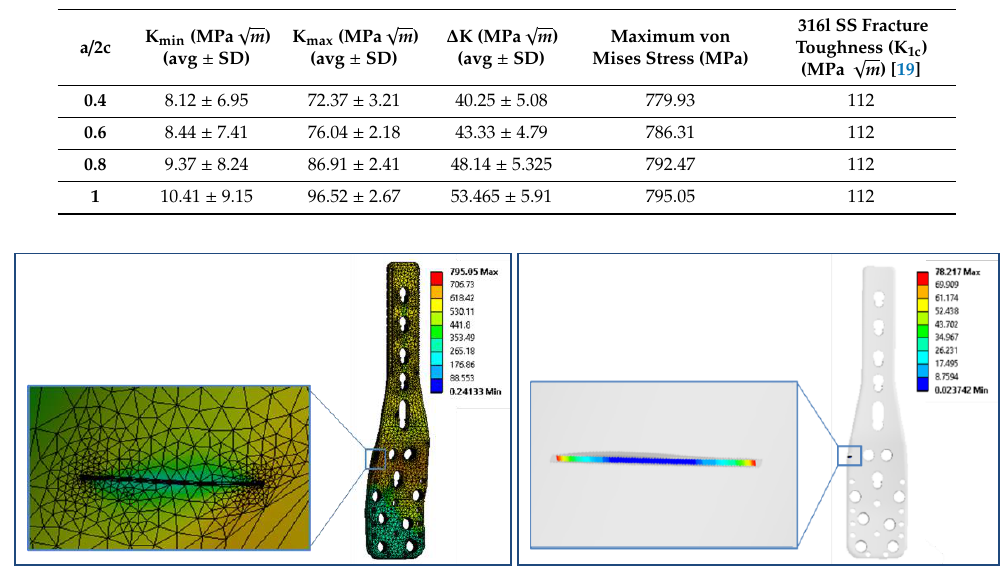
Table 3. The stress intensity factors, maximum von Mises stresses, and fracture toughness for each crack length.